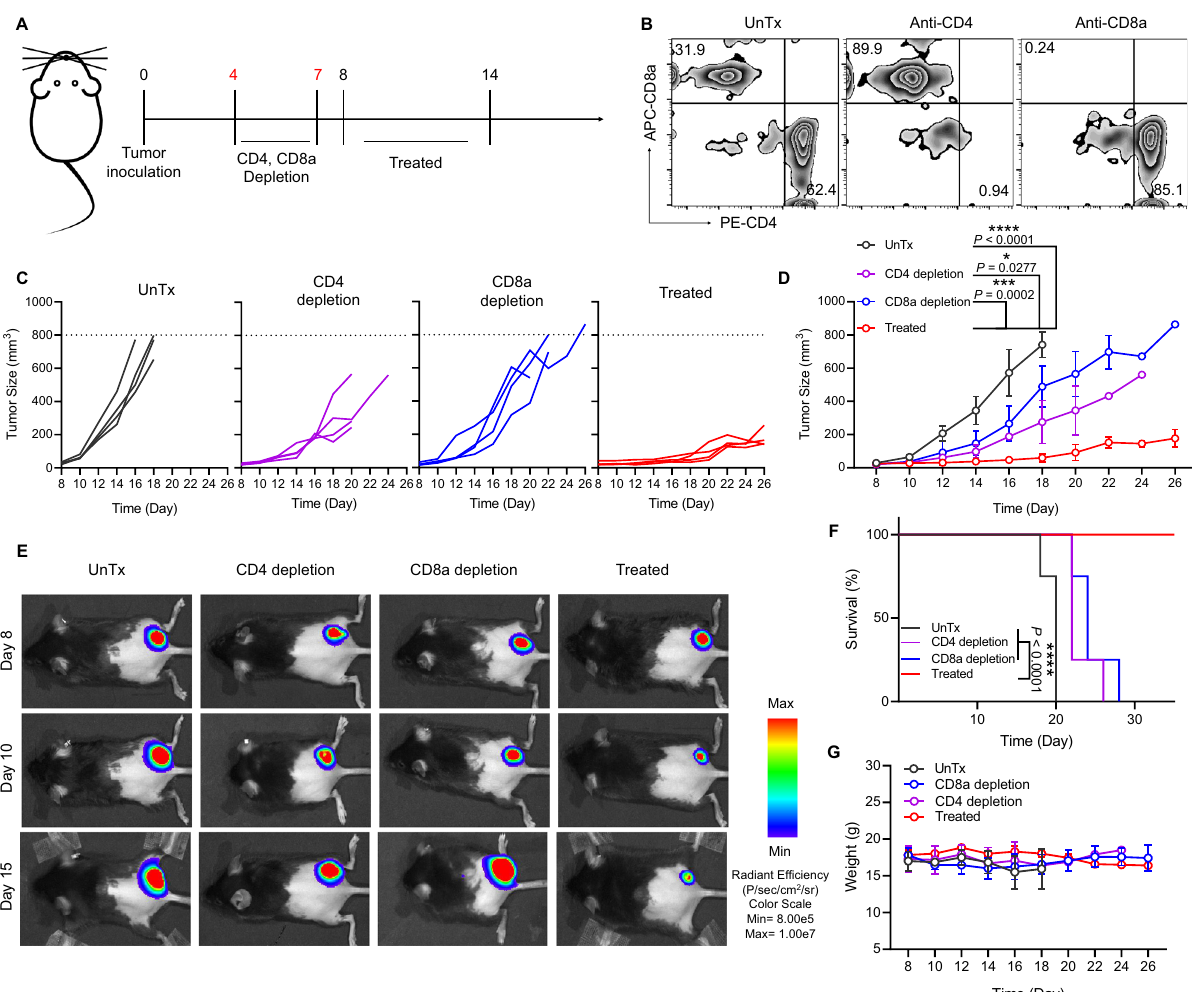
Fig. 5 T-cell-mediated anti-tumor immune responses induced by small size of YCW NPs. A Schematic diagram of therapeutic strategy with T cell depletion, including CD4 depletion and CD8a depletion. B Representative fl ow cytometric analysis for CD8 + and CD4 + in CD3 + T cells in peripheral blood to con fi rm the depletion of CD4 and CD8a in vivo. C – D Individual ( C ) and average ( D ) tumor growth curves in four groups, including UnTx group, CD4 depletion group, CD8a depletion group and treated group. E Fluorescence imaging of B16-luc established mice on day 8, 10, 15 in four different groups. F Survival curves for the depletion groups and treated group. G Weight curves of different groups. Statistical signi fi cance was obtained by one-way ANOVA using the Tukey post-test ( n = 4). **** P < 0.0001; *** P < 0.005; * P < 0.05. Data are means ± SD. MFI: mean fl uorescence intensity, arb. units: arbitrary